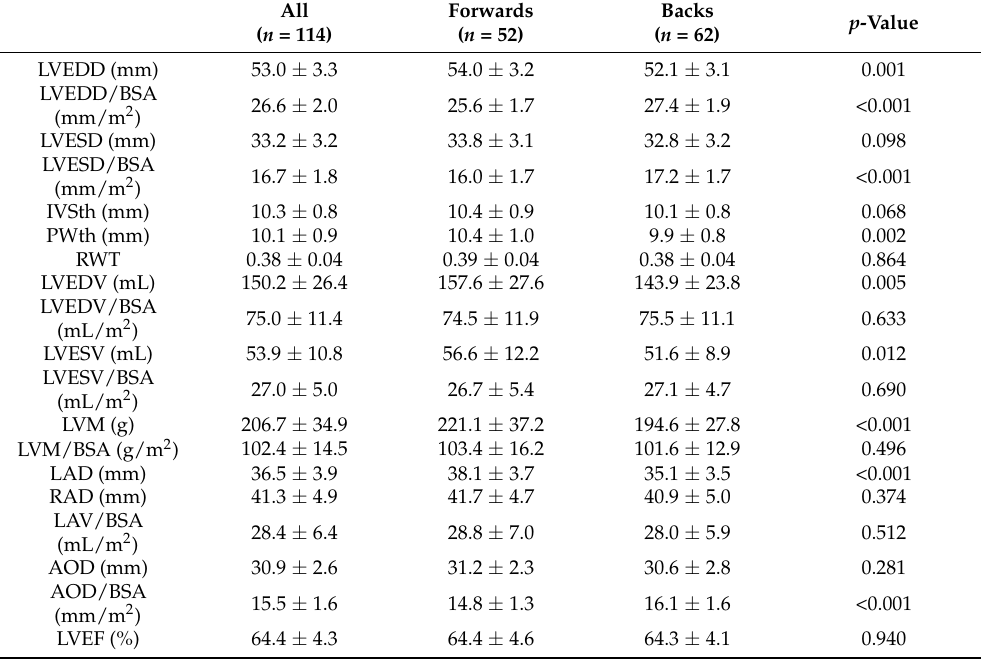
Table 3. Echocardiographic parameters of young Japanese rugby